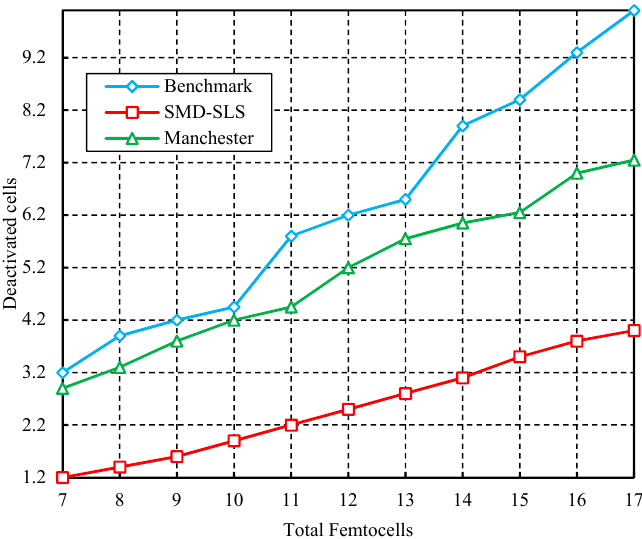
Figure 8. Deactivated cells in a number of femtocells.